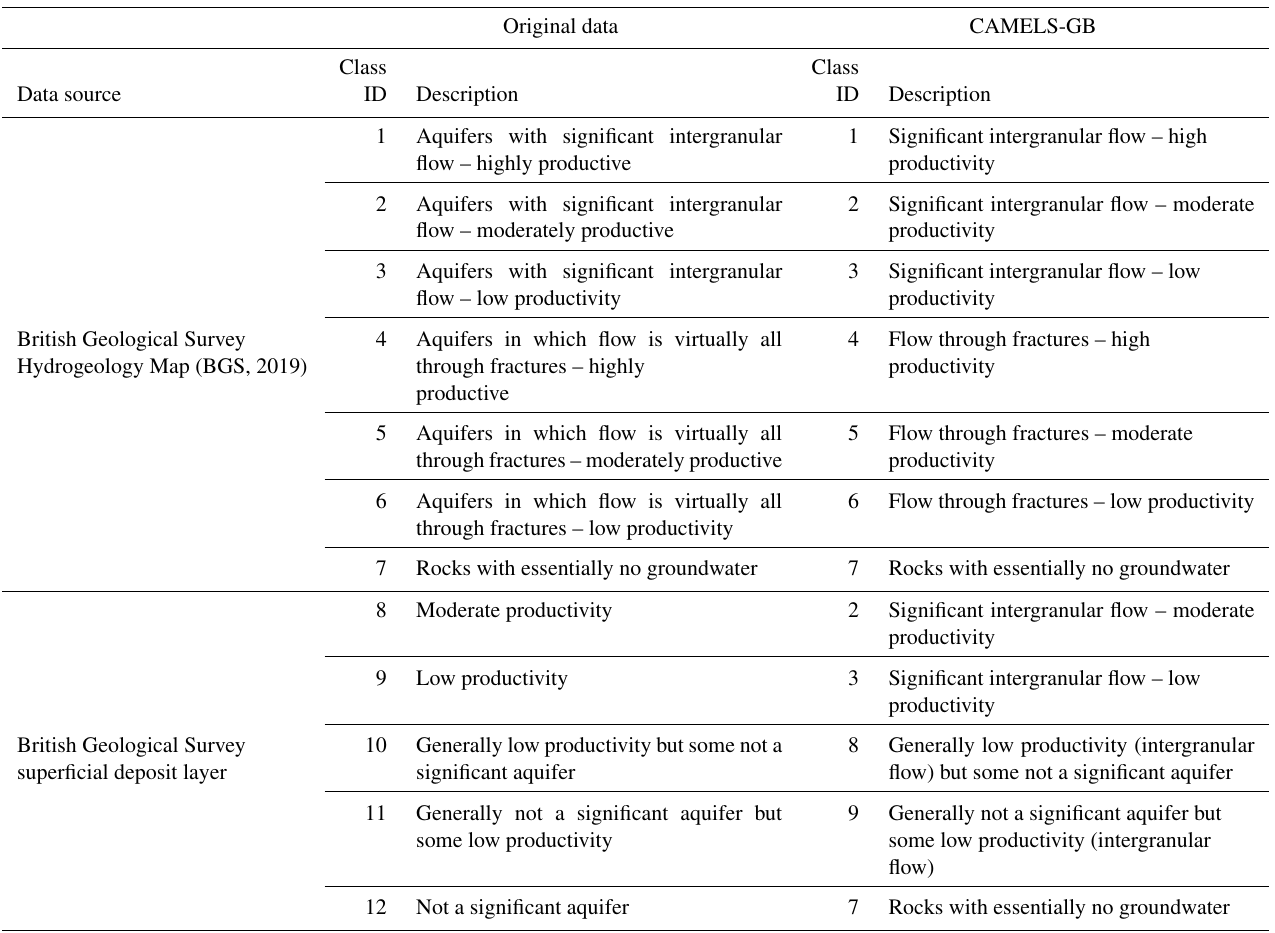
Table D1. Data source, class, and description of the hydrogeologi- cal